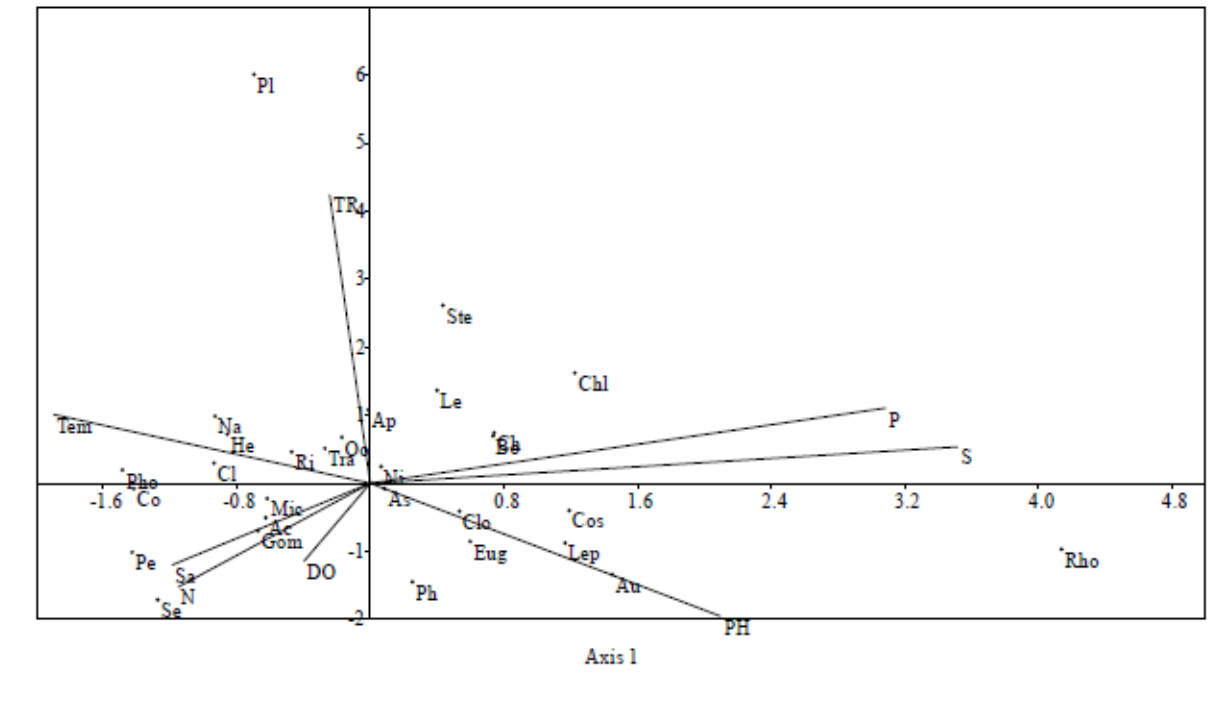
Figure 6. CCA bi-plot between 30 dominant algae genera and 8 physico-chemical parameters.